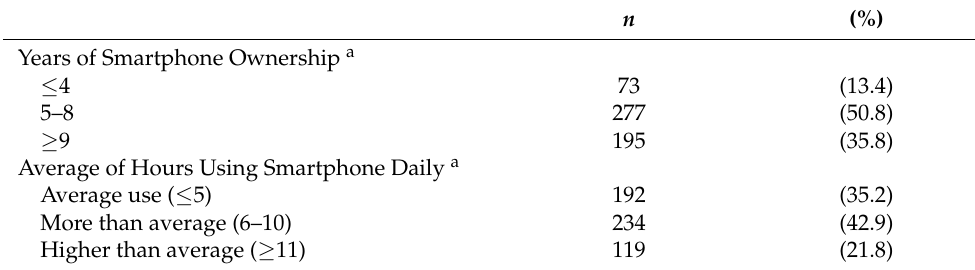
Table 2. Distribution of smartphone ownership and daily use, N =